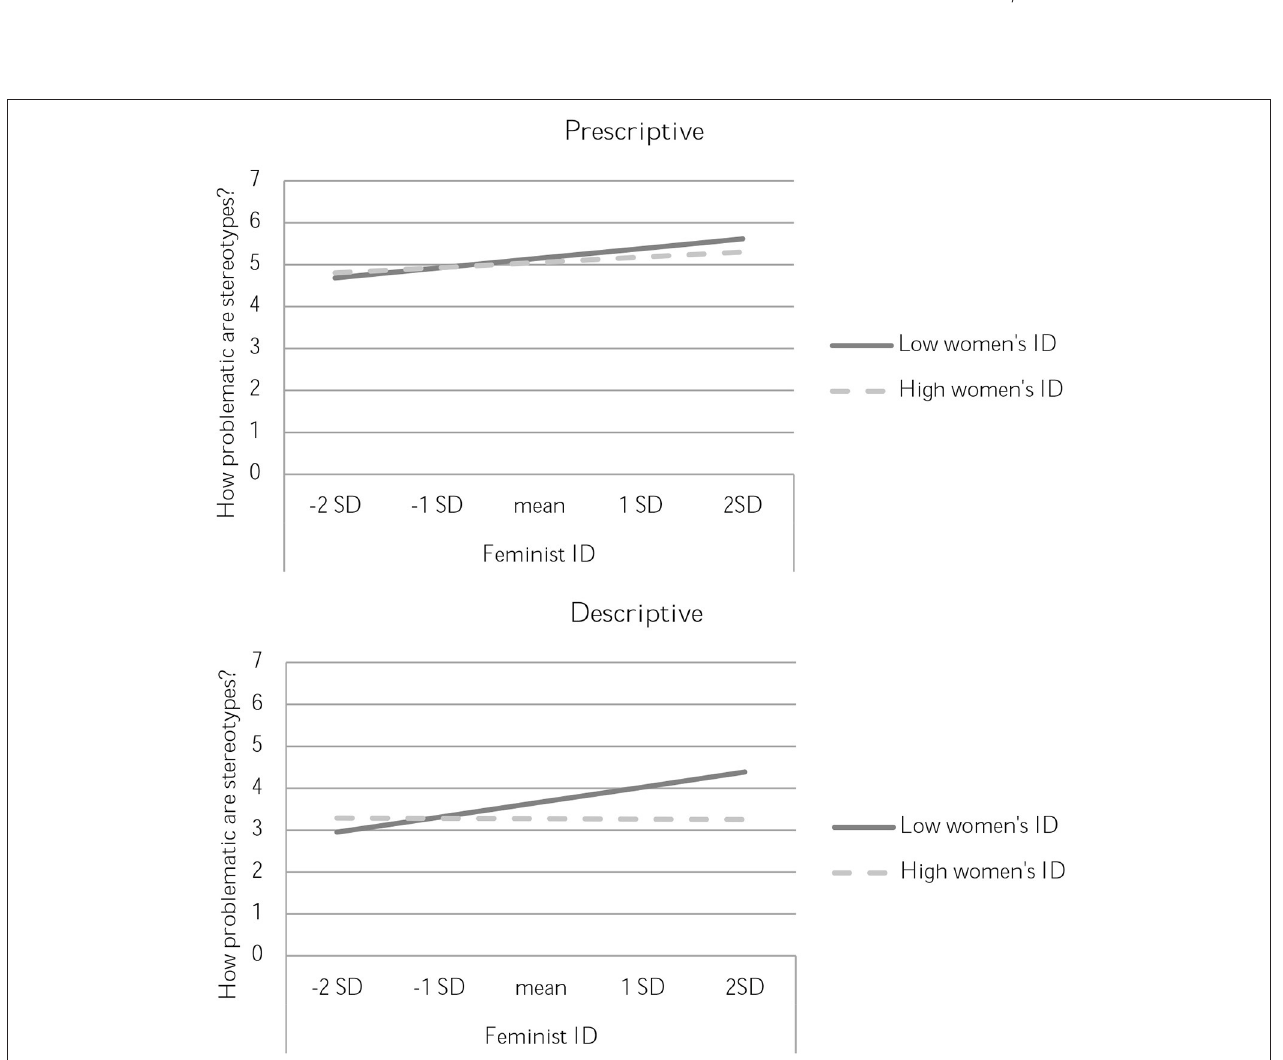
FIGURE 2 | Perceptions of the problematic nature of stereotypes in Study 4, separated by valence of the stereotype and prescriptive (top) vs. descriptive (bottom) nature. High and low women’s identification are plotted at ± 1 standard deviation from the mean.